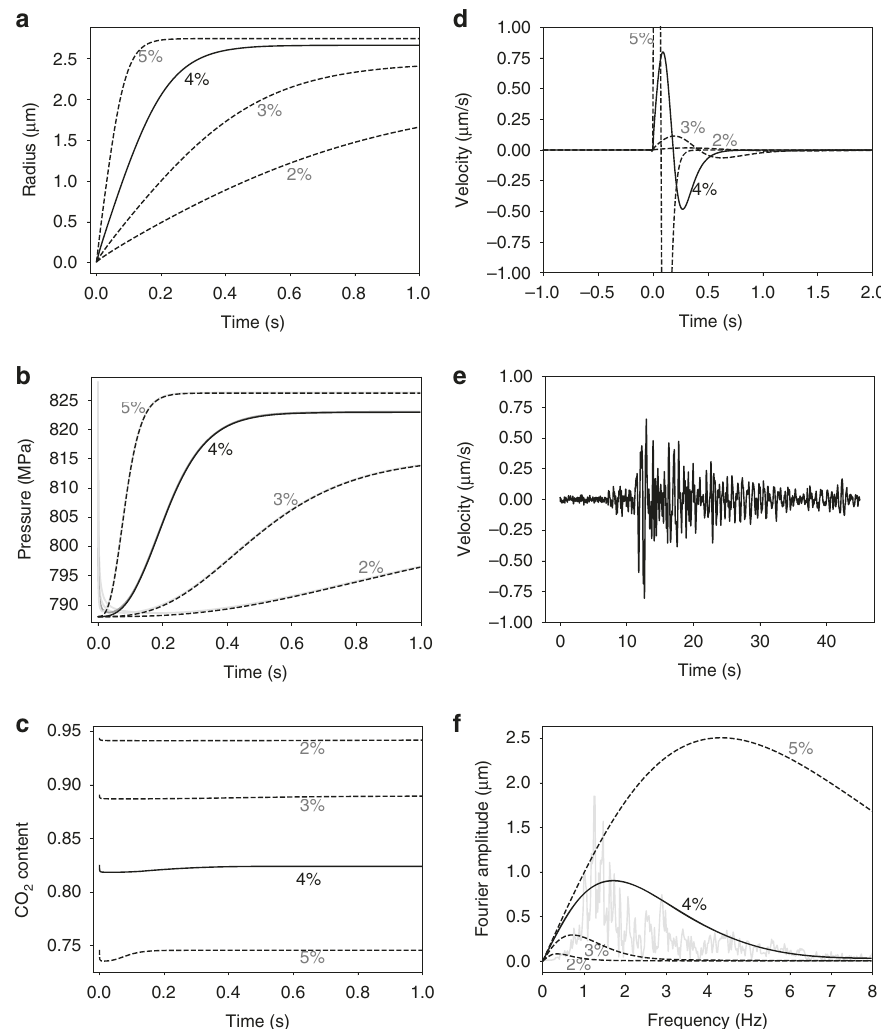
Fig. 3 Modeled dynamics of the bubble grows and magma pressure change. Results are shown for the bubble number density of 10 13 m − 3 , four different water contents indicated with wt% values in respective plots, and for CO 2 content computed for 828 MPa (red circles in Fig. 2). a Evolution of the bubble radius. b Evolution of magma pressure P m ( P g values are shown with gray lines). c Evolution of the CO 2 content in bubbles. d Ground velocities estimated for a source located at a 30 km distance from the receiver (Additional information provided in Methods). e Example of real seismogram (east-west component at station LGN, Supplementary Fig. 1). f Fourier amplitudes computed from synthetic and real (gray line)